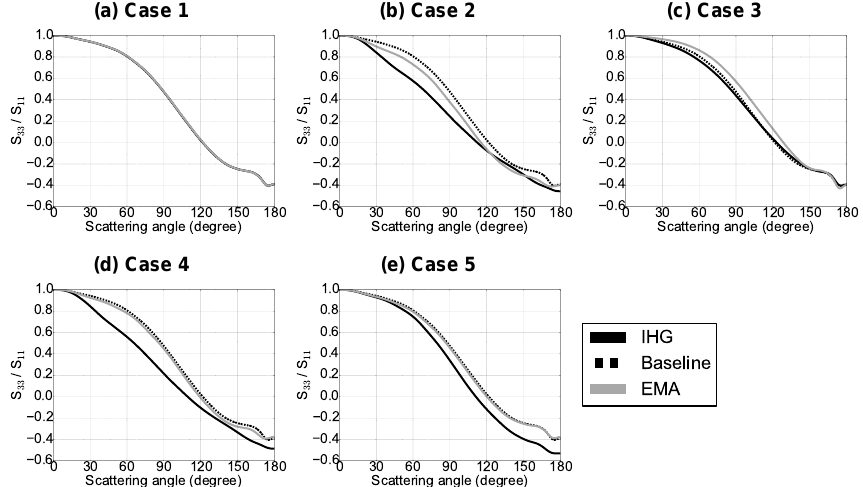
Figure 7. S 33 /S 11 values for the inhomogeneous (IHG), the baseline, and the homogeneous (EMA) versions of all five of the internal structure cases as a function of the scattering